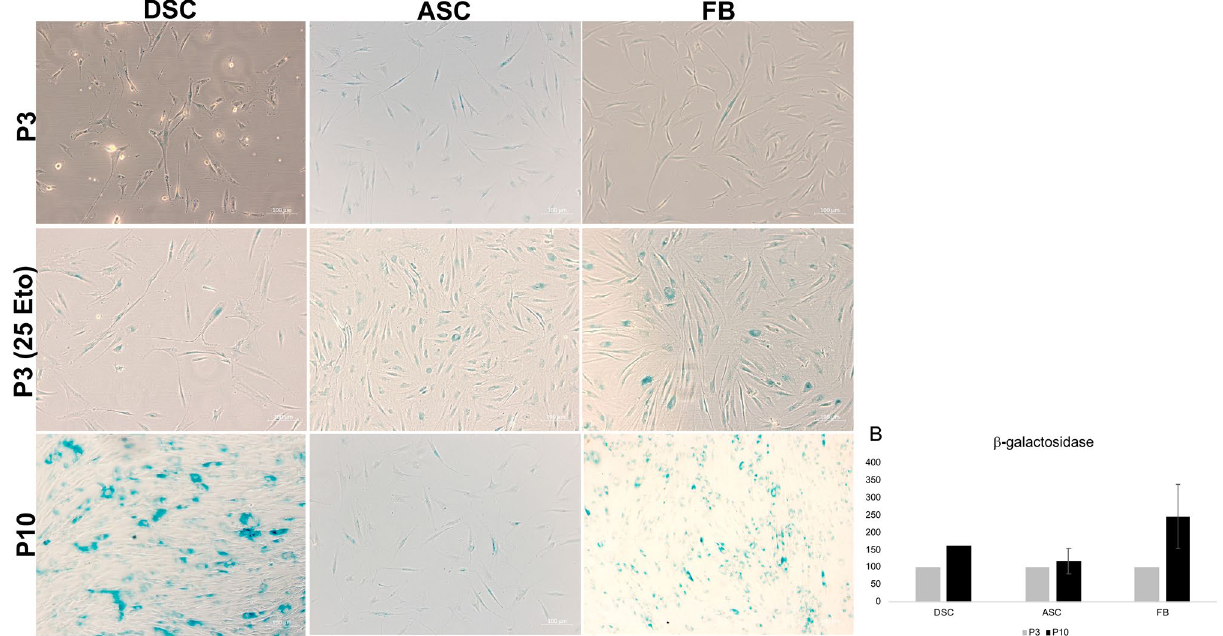
Figure 8. Evaluation of senescence associated β-galactosidase activity. ( A ) Visualized comparison of β-galactosidase activity at P3 and P10 . At P3 in DSC, ASC and FB β-galactosidase activity was on a comparable level. Control cells treated with etoposide, showed an increase of β-galactosidase activity. At P10 DSC and FB showed a noticeable stronger β-galactosidase staining compared to ASC. Shown are representative illustrations of at least six identical results. The image scales represent a length of 100 µm. ( B ) Evaluation β-galactosidase expression at P3 and P10. In ASC β-galactosidase expression was on a comparable level in P3 and P10. In DSC and FB the β-galactosidase expression noticeably increased in P10 in contrast to P3. Bars represent mean ± SD of two